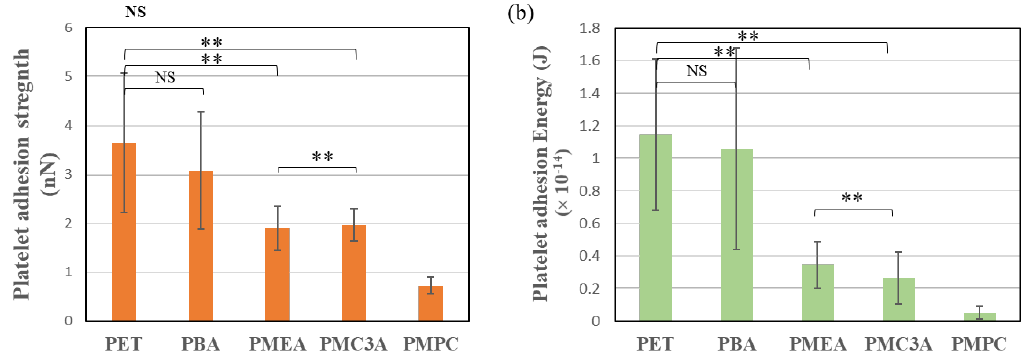
Figure 6. Comparison of ( a ) platelet adhesion strength and ( b ) adhesion energy on different polymer substrates. The data represent the mean ± SD ( n > 5), ** p < 0.05 (vs. PET and NS = Not Significant).